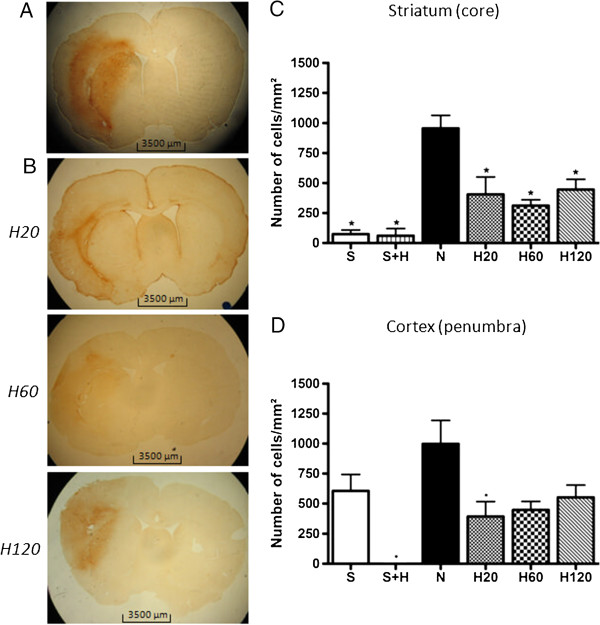
Effect of hypothermic treatment on the Et-1 induced increase in CD-68 expression. (A) shows the expression of CD-68 in a rat of the N group and (B) in a rat of the H20, H60 and H120 group, respectively. The graphs show the overall expression in the striatum (C) and the cortex (D) for the different treatment protocols. The number of rats in the S and S + H group is 7 and 4 respectively; in the N group 12 and in every H group 7. Data are expressed as the number of cells/mm2. There was no binding of the second antibody in the absence of the primary antibody (data not shown). *Significantly different compared to the N group. For a more detailed image we refer to a previously published article by Ceulemans et al.
[37].